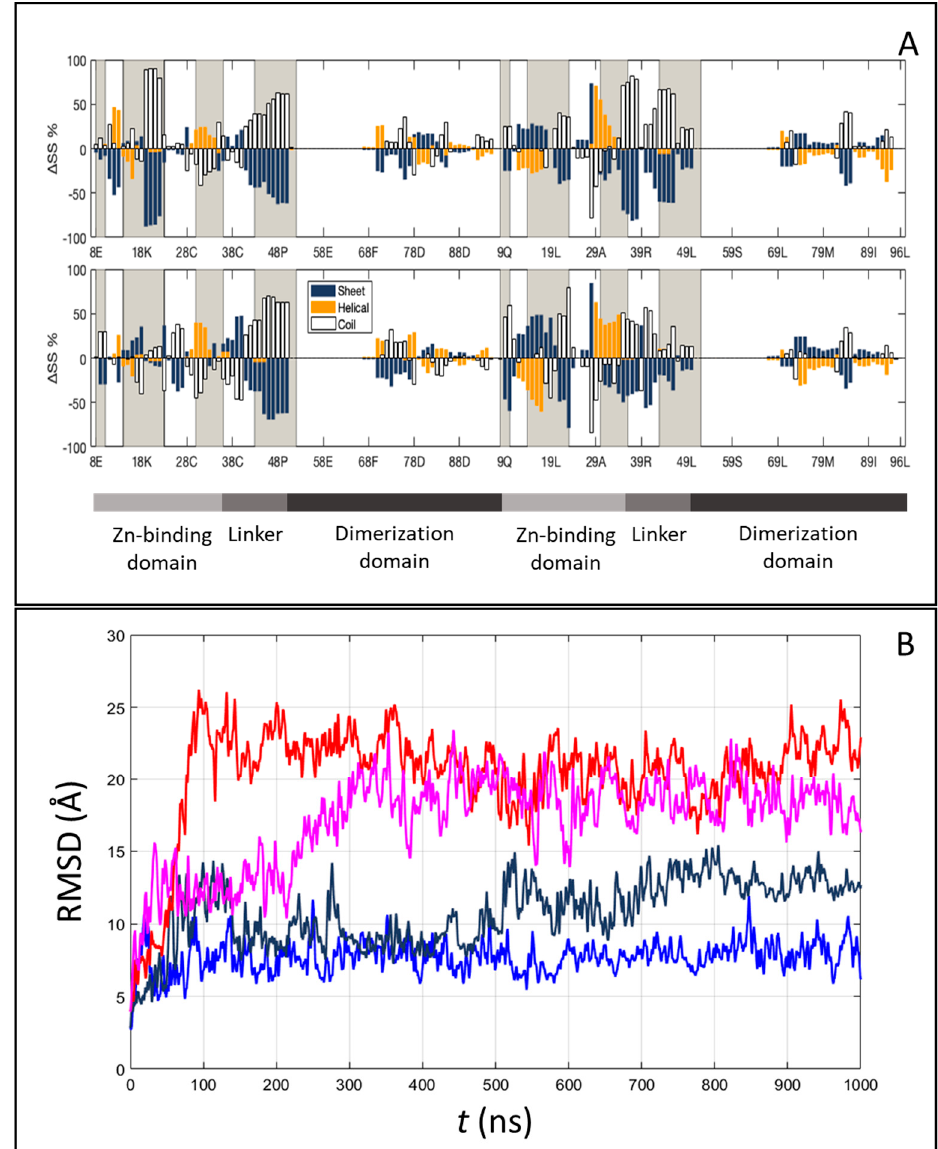
Figure 6. Conformational and translational freedom within the Gal4–DNA complex from molecular simulations. ( A ) Difference in the average protein secondary structure percentage calculated along the molecular dynamic (MD) simulations, between the specific complex and the isolated protein (top) or the nonspecific complex and the isolated protein (bottom). Gained and lost secondary structures are expressed as positive and negative bars, respectively. The grey regions represent the interface portions in the protein. ( B ) Protein movements along the DNA are computed as the Root Mean Square Deviation (RMSD) of the protein after the superposition of DNA heavy atoms, with specific (blue and dark blue) and nonspecific (red and magenta) sequences.